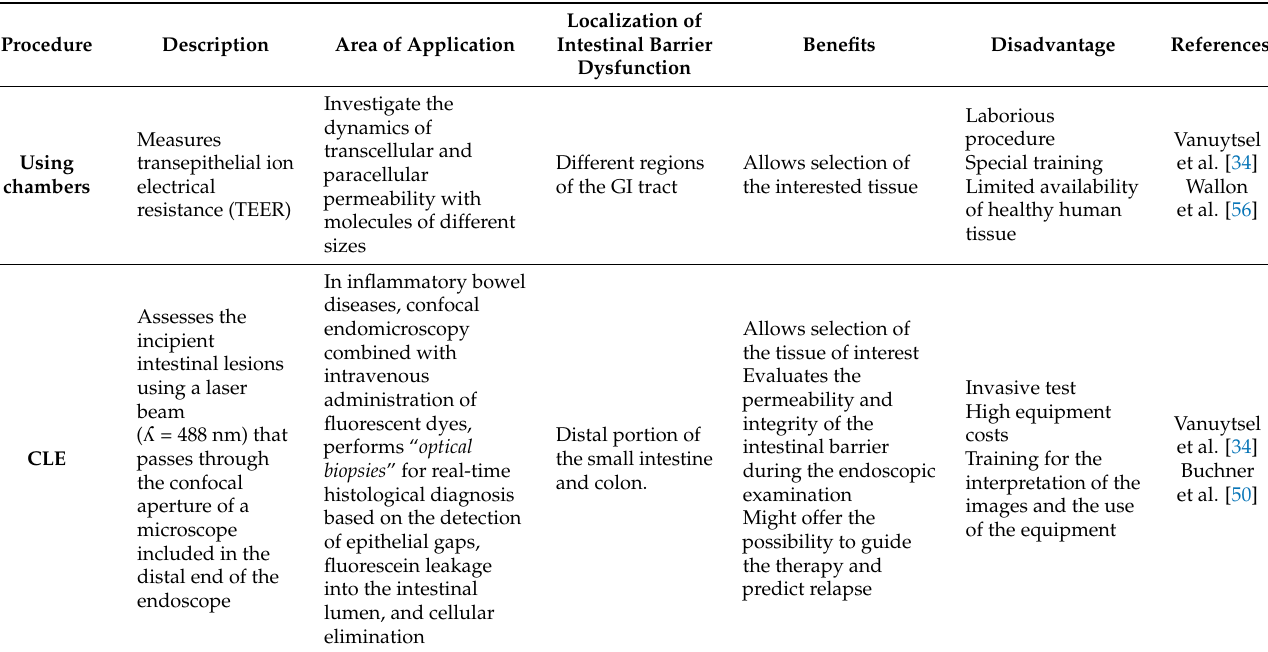
Table 1. Tests used in the assessment of intestinal permeability in IBD.